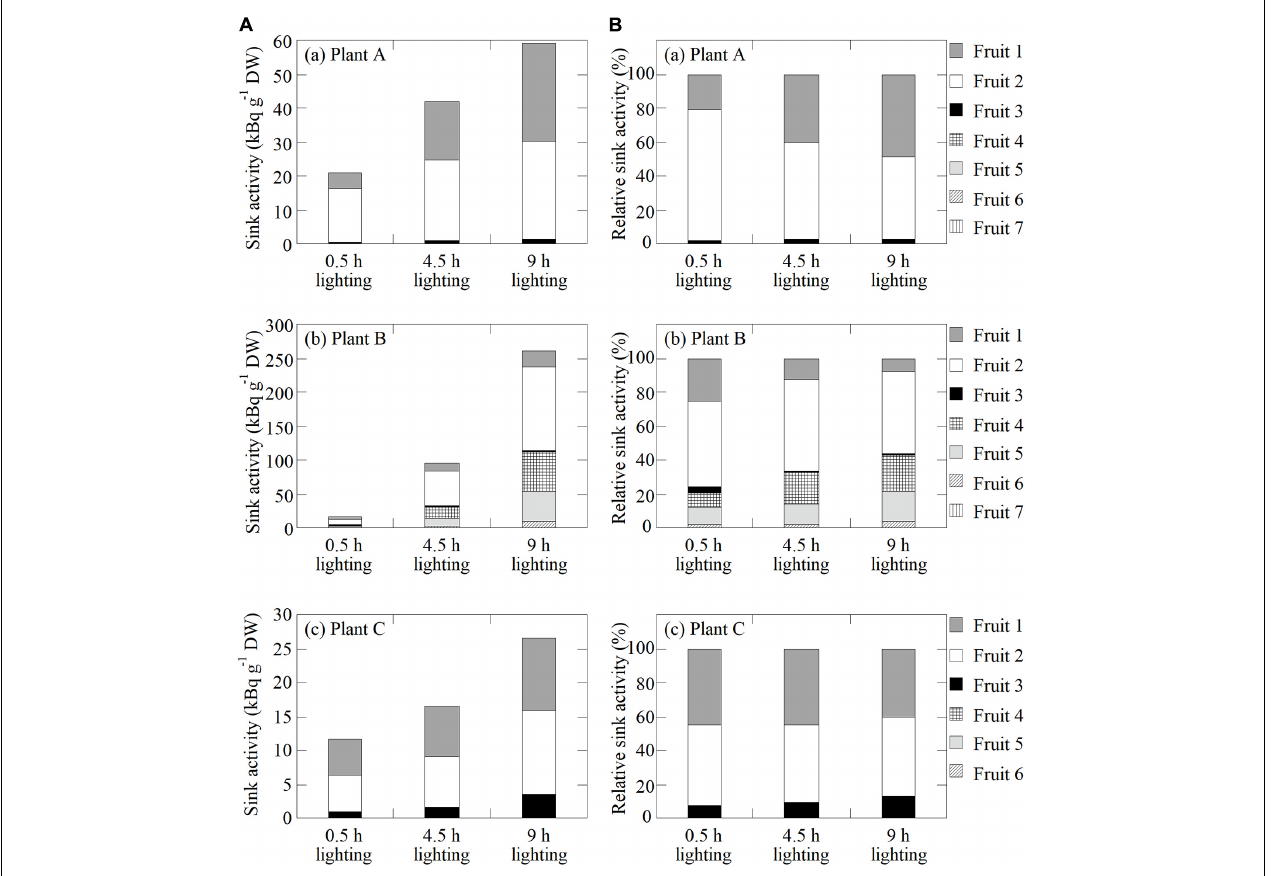
FIGURE 7 | (A) Sink activity of all fruits in (a) Plant A, (b) Plant B, and (c) Plant C in response to the 0.5-, 4.5-, and 9-h lighting treatments. (B) Relative sink activity of all fruits in (a) Plant A, (b) Plant B, and (c) Plant C for each lighting